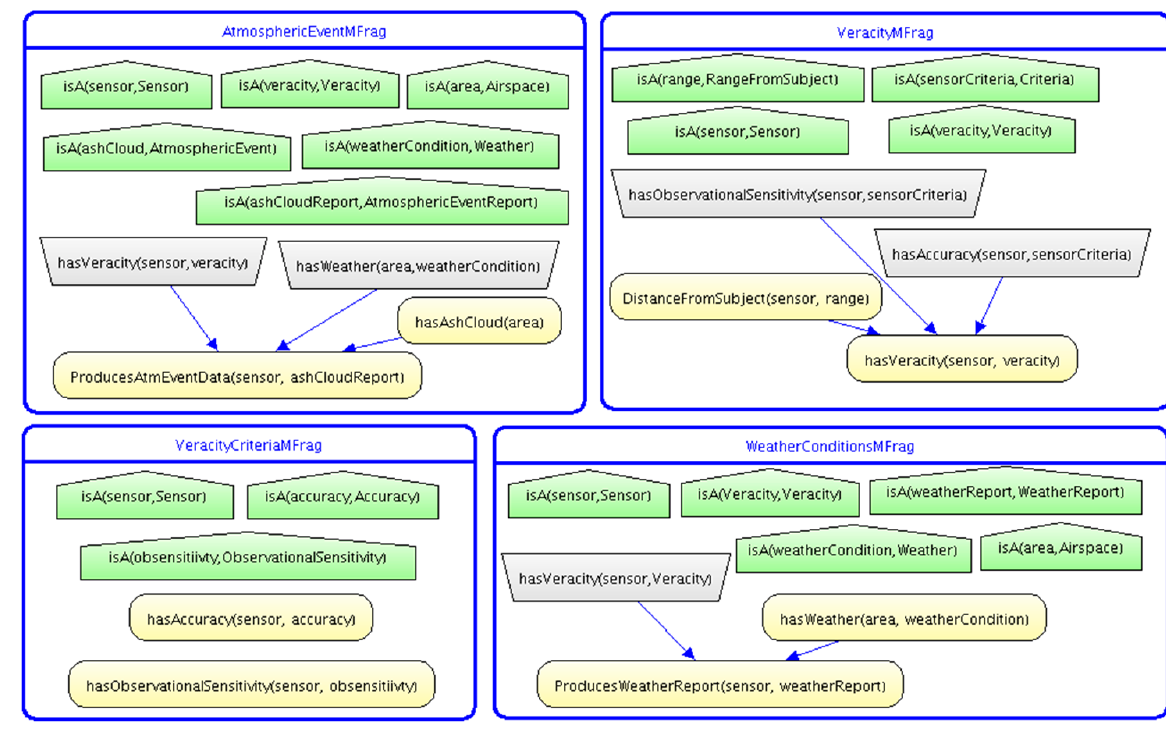
Figure 16. Extended AAO MTheory.